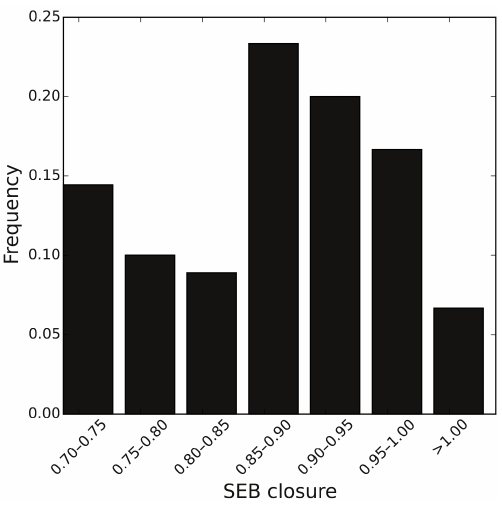
Figure 7. Histogram of surface energy budget closure for 86 site- years of data from 23 OzFlux